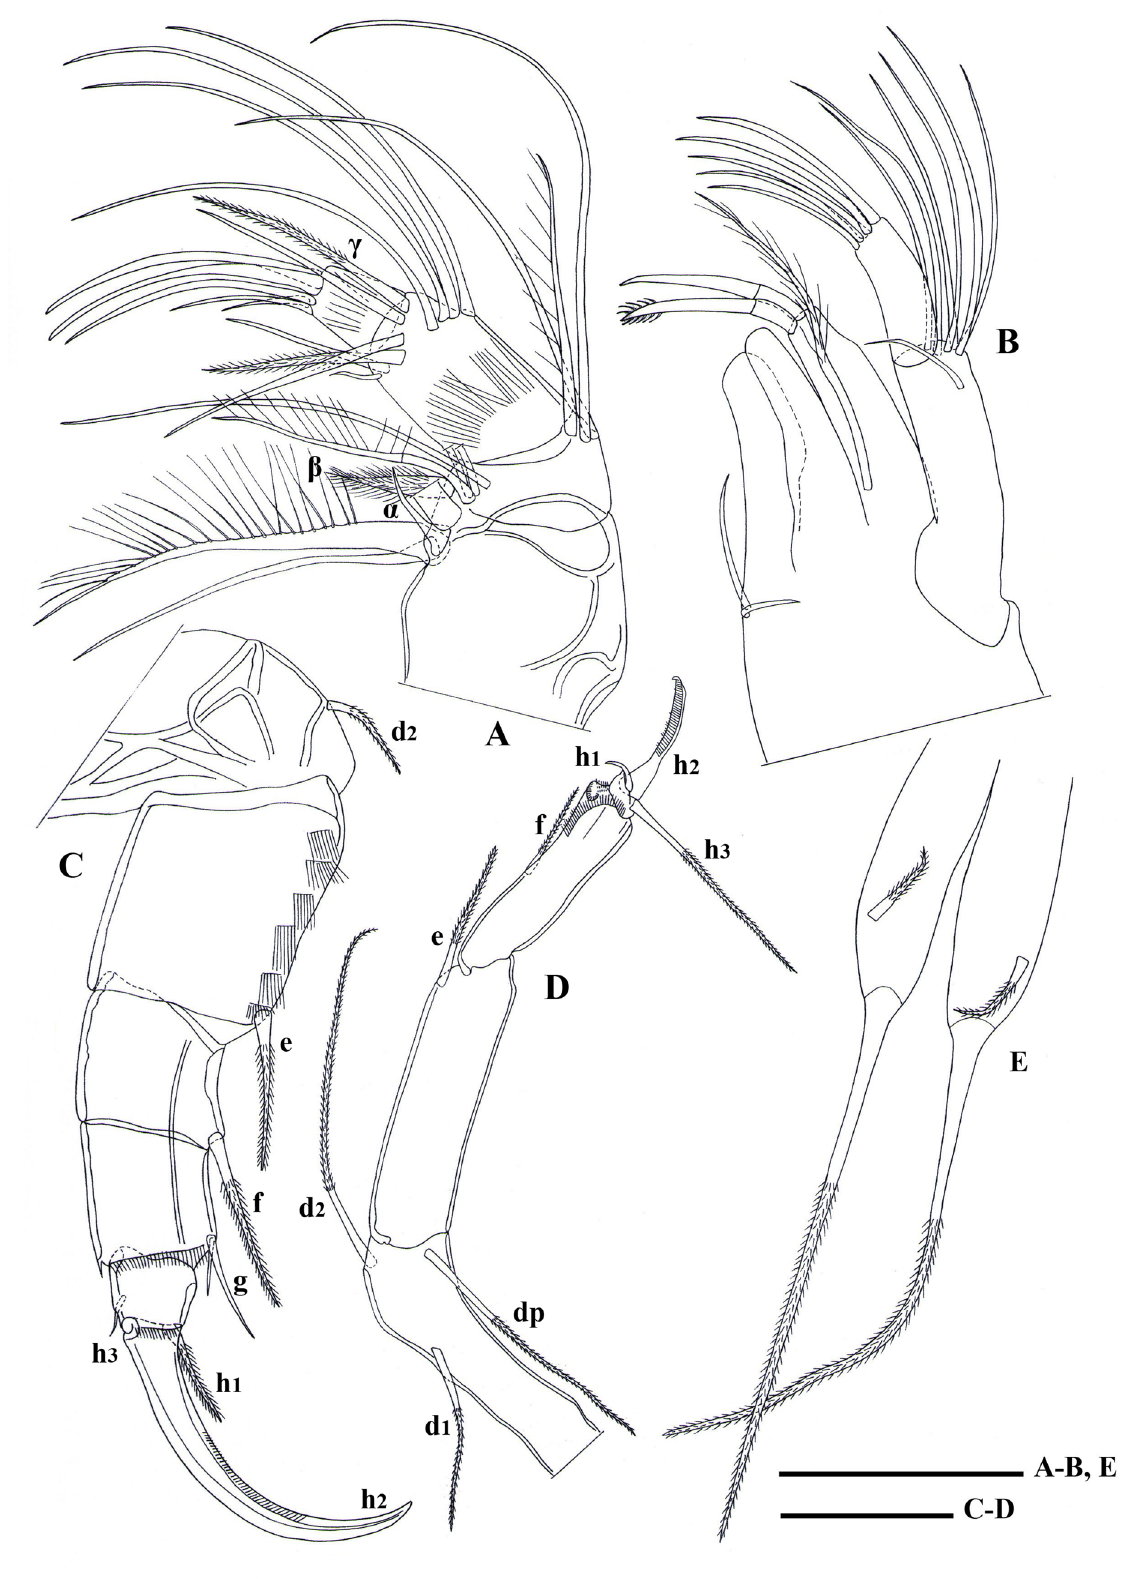
Fig. 7. Siamopsis suttajiti gen. et sp. nov., ♀ (MSU-ZOC.195). A . Md palp. B . Mx1. C . T2. D . T3. E . CR. Scale bars: 50